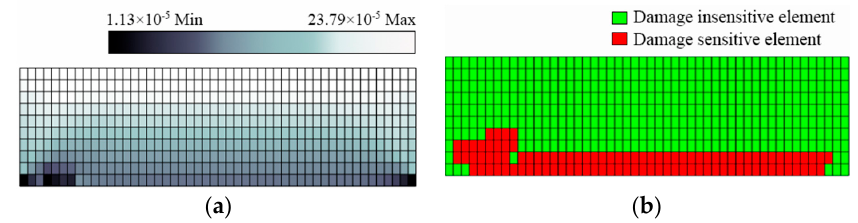
Figure 4. Simulation results for Scenario A with a stiffness reduction of 80%: ( a ) contour for strain variation; ( b ) damage-sensitive area indicated by finite elements in red.